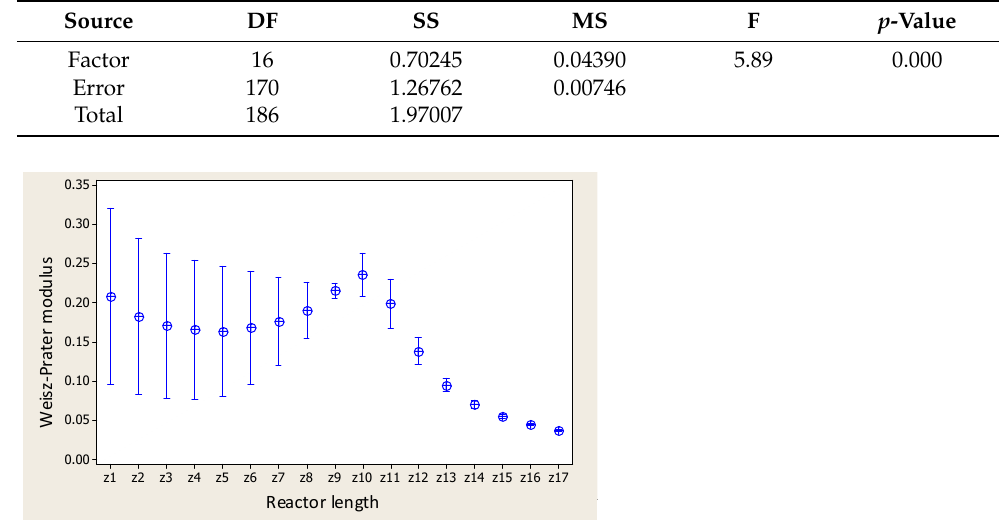
Figure 10. Weisz–Prater modulus vs. length reactor (obtained from Table A4). Interval plot 95% CI for the mean. Table 7. Analysis of variance of the Weisz–Prater modulus versus the reactor longitude.